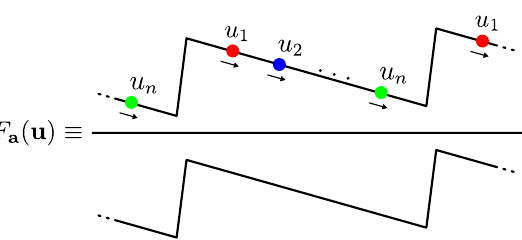
Figure 3 . The FF transition is given by the ratio between the expectation value of the two-sided wrapped polygon with and without GKP excitations inserted on its